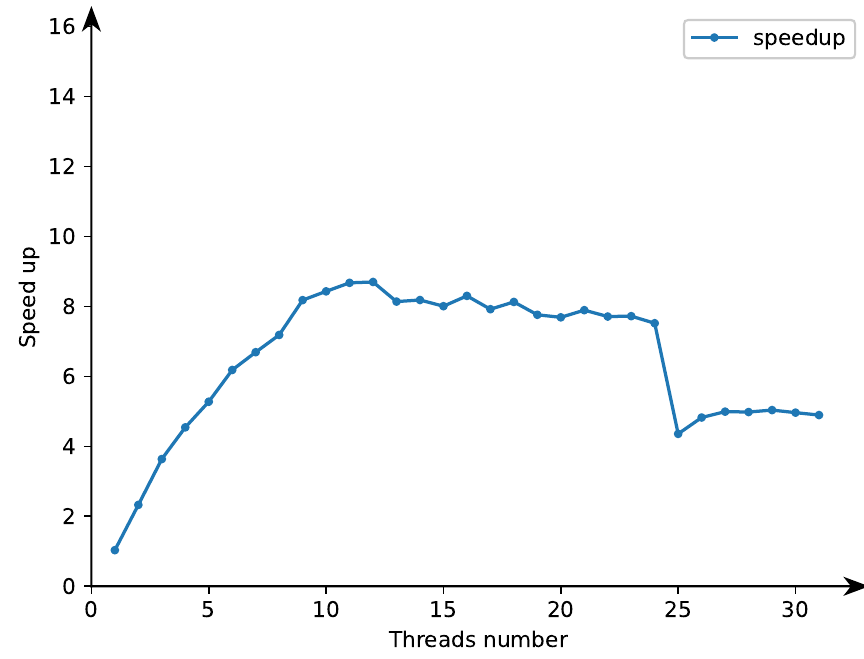
Figure 4. Speedup for Intel Xeon X5570 for different threads